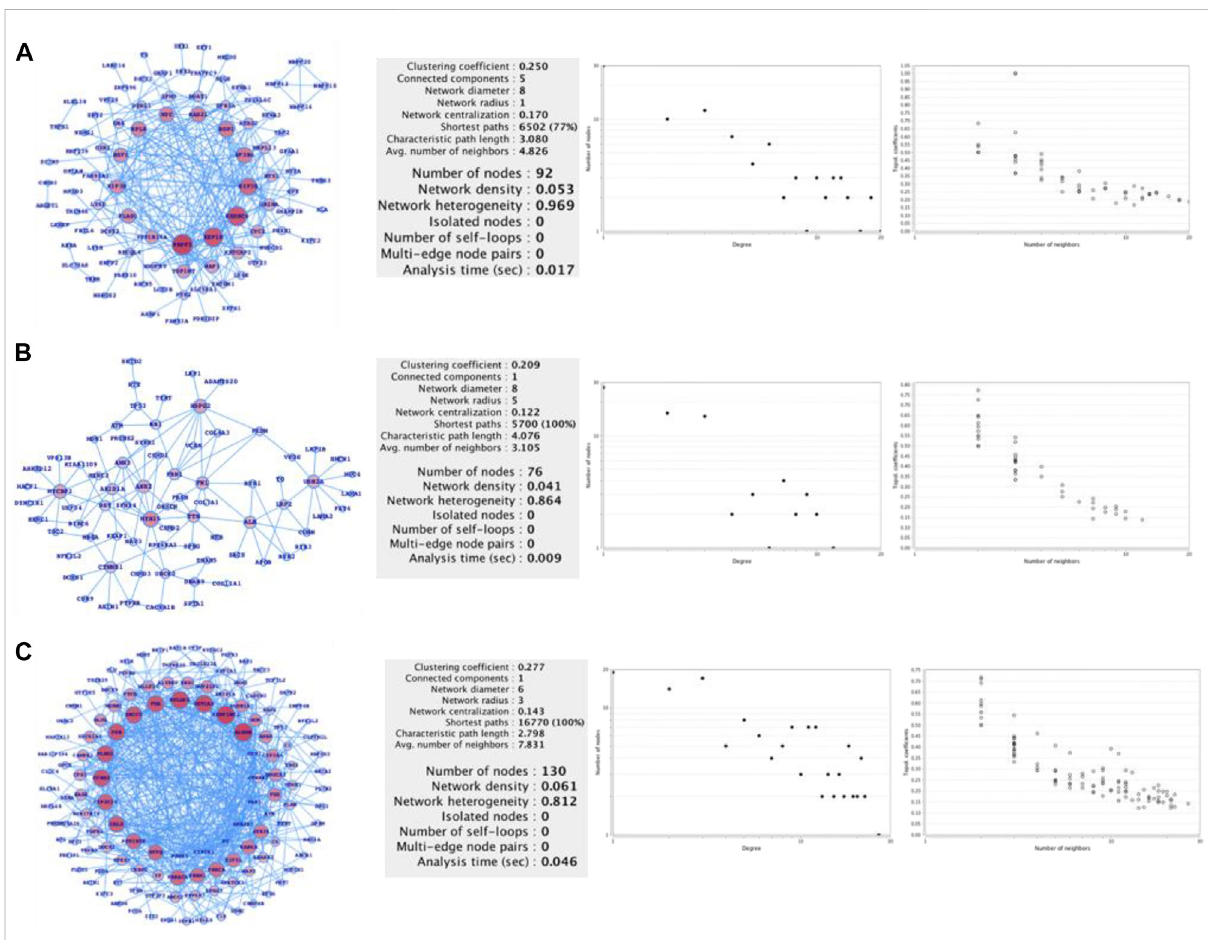
FIGURE 3 Network-level understanding top-ranked genes. (A) CNA genes network, (B) Mutated genes, and (C) SV genes network followed by their respective analysis (degree distribution and topological coef fi